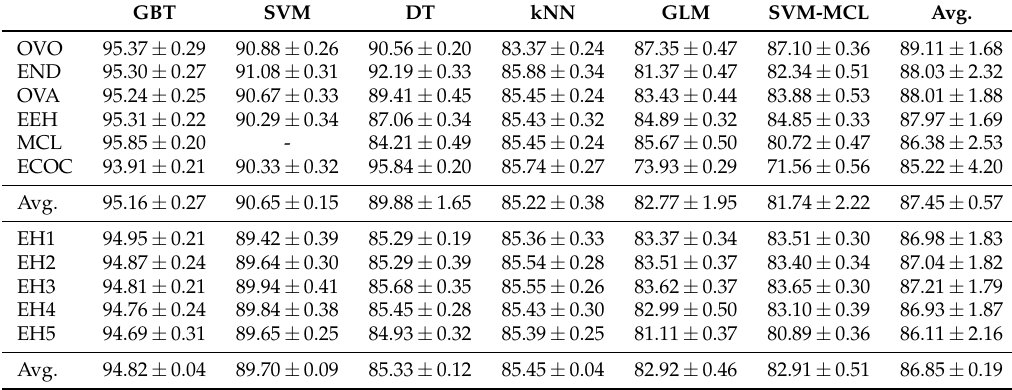
Table 2. Mean κ % (± SE) on the multi-class human activity recognition (HAR) problem for each machine learning algorithm and multi-class decomposition method. The first six multi-class decomposition methods are given in order of decreasing average score, the expert hierarchies ordered